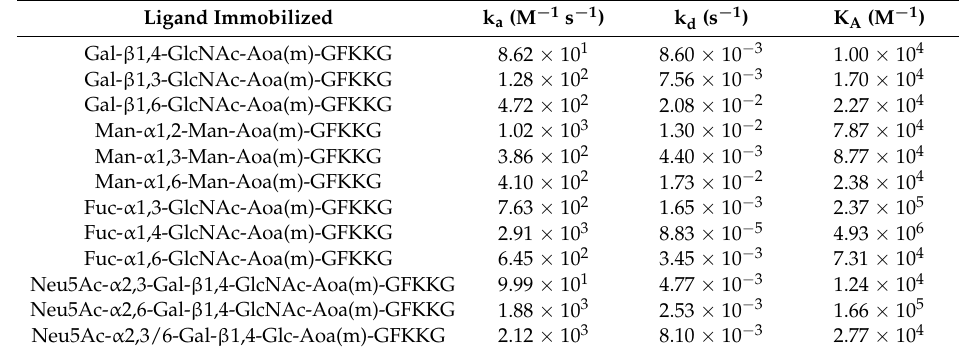
Table 4. Kinetic rate constants and derived association (K A ) constant of PDC-109 to various neo-glycoprobes as determined by